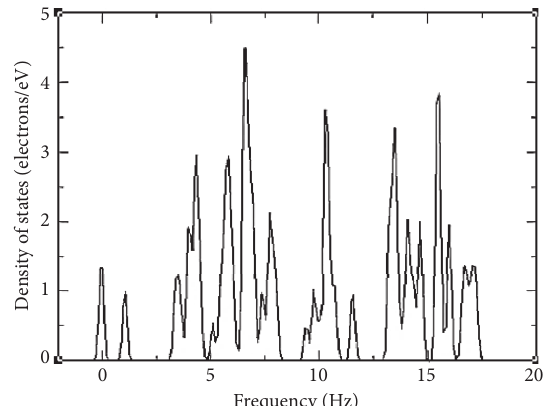
Figure 5: The plotted phonon density of states. As the wavelength becomes longer, the frequency of the acoustic modes of vibration goes to zero, while for longer wavelengths in optical phonons, the frequency does not go to